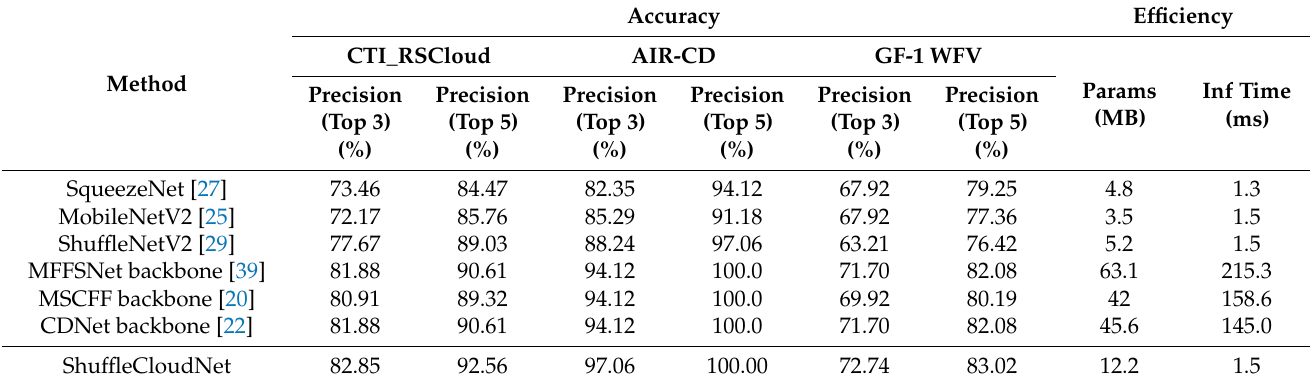
Table 6. Comparison of the performance of different methods for cloud-amount calculation.